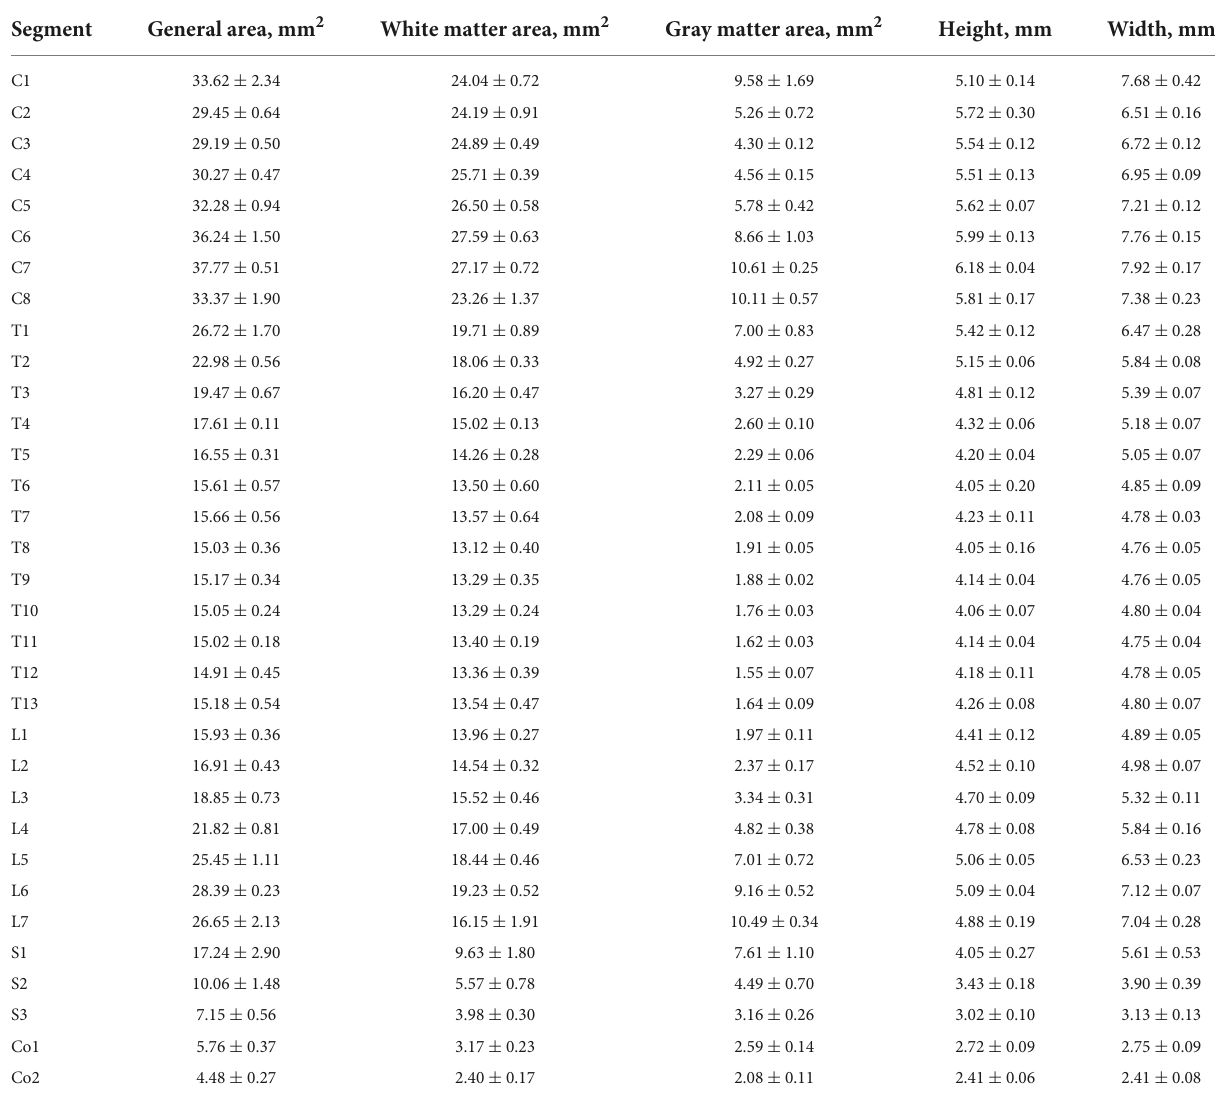
TABLE 3 Morphometric parameters of spinal